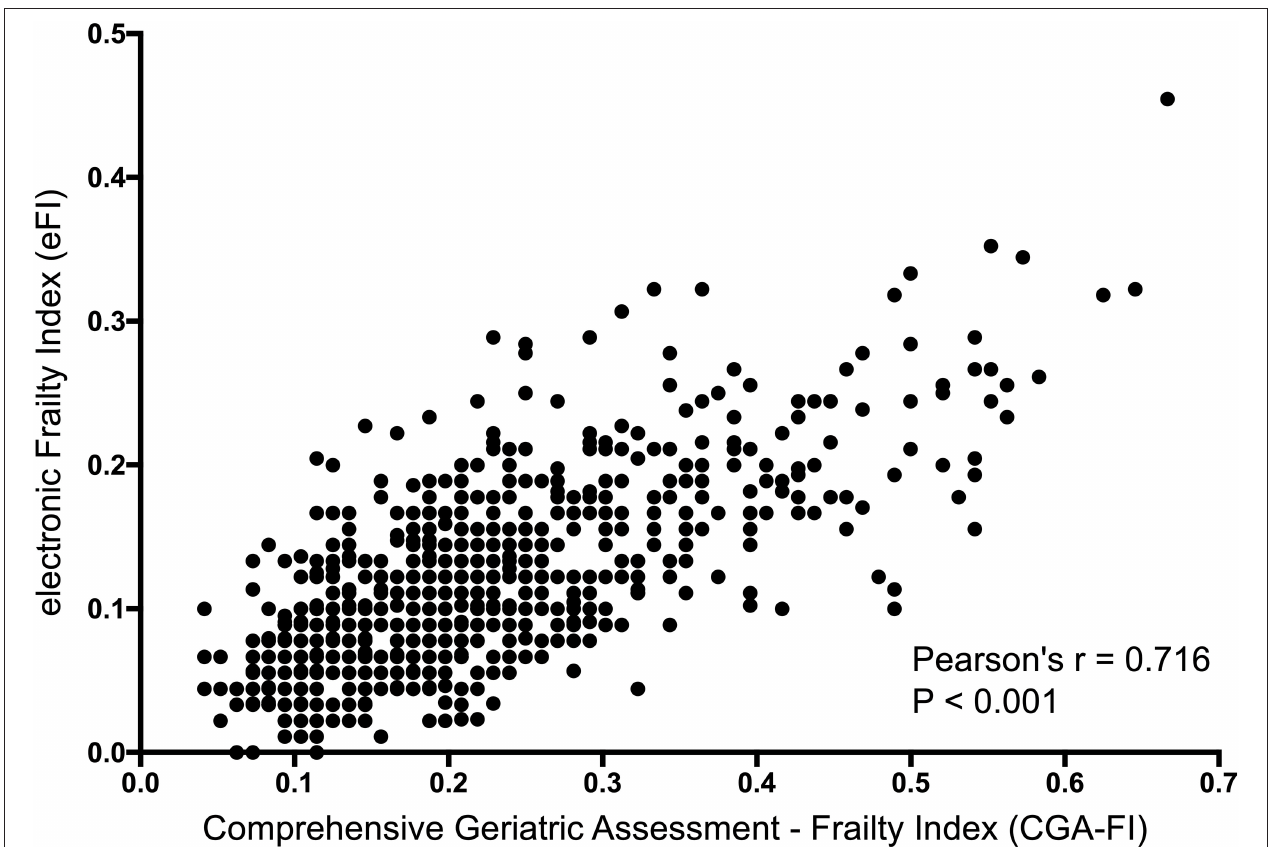
FIGURE 3 | Correlation between the eFI and CGA-FI. eFI, electronic frailty index; CGA-FI, comprehensive geriatric assessment-frailty